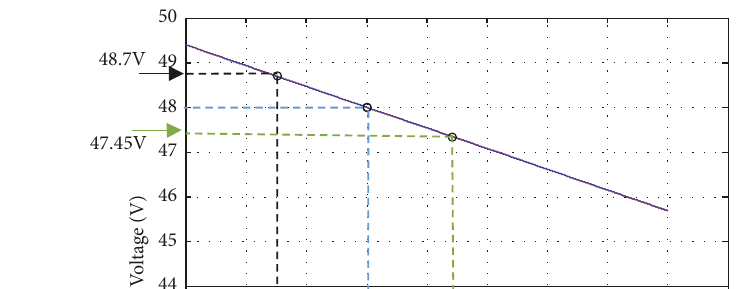
Figure 11: Flowchart of the proposed algorithm.